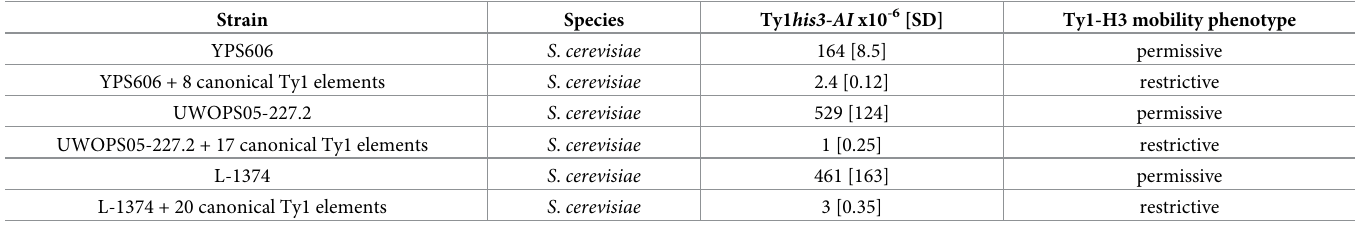
Table 2. Canonical Ty1-H3 mobility in natively permissive S . cerevisiae strains populated with canonical Ty1-H3 elements.